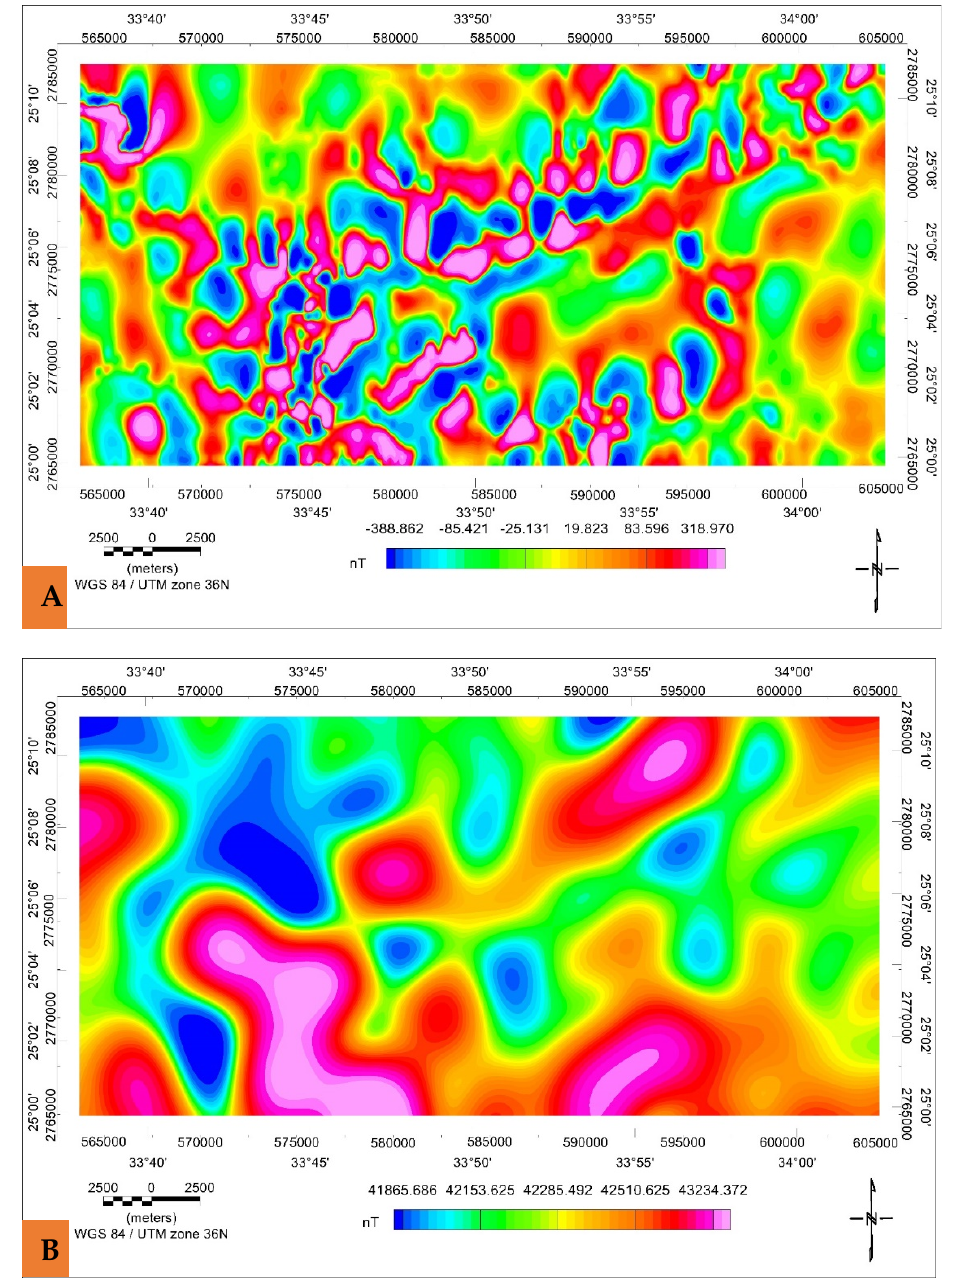
Figure 5. ( A ) High-pass filtered map; ( B ) Low-pass and filtered map of the study area. The magnitude of magnetic anomalies varies between 1.175 and − 2.540 nT/Km on the FVD map in greyscale (Figure 6A) and extends in the NE–SW, NW–SE, and N–S directions. The high magnetic anomalies are linked to ophiolitic serpentinite rocks, gabbroic rocks, and metavolcanic rocks, and this is indicated by the Barramiya–Um Saltit mineralization belt, whereas the low magnetic anomalies are associated with sedimentary cover, metasediments, and calc-alkaline rocks. Short-wavelength anomalies were discovered in the northeast and eastern parts of the research area, indicating shallow depths of the causative sources in comparison to the western section, which showed deeper sources associated with the presence of sedimentary deposits. The three alteration zones, which run NE–SW, E–W and NW–SE, are clearly seen here.